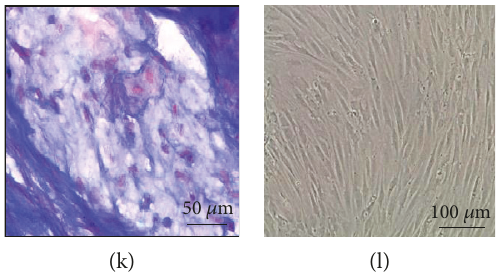
Figure 3: Characterization of canine AT-MSCs. (a) Phase-contrast micrograph showing AT-MSCs adhered to a plastic culture fl ask at passage 3. (b) Immunophenotypic pro fi le. Flow cytometry analyses were carried out for each marker separately. The percentages of positive cells are shown in the graph. (c, d) Adipogenic di ff erentiation. Cells were grown in regular (c) or adipogenic (d) medium for 21 days, fi xed, and stained with oil red O to evaluate the presence of red-colored lipid drops in the cytoplasm. The insets correspond to higher magni fi cations of areas boxed in (d). (e – h) Osteogenic di ff erentiation. Alkaline phosphatase (ALP) activity was measured after 7 or 14 days of culture in osteogenic medium (right bars) or regular medium (left bars), as indicated in (e). Bars labeled with the same letters are signi fi cantly di ff erent ( p ≤ 0 05 ). Von Kossa staining revealed more mineralization foci at day 7 in induced cells (f). (g, h) show the absence or presence of mineralization deposits in osteogenic and regular medium, respectively. (i – l) Chondrogenic di ff erentiation. (i) Scheme representing the micromass assay. (j) Micromass generated after 21 days in chondrogenic medium after being processed, cut, and stained with alcian blue and counterstained with neutral red to evidence cell nuclei. (k) Selected area in (j), showing the typical structure of cartilage tissue with nuclei eccentrically placed in lacunae and an alcian blue-stained matrix revealing the presence of glycosaminoglycans. (l) No micromasses were observed after 21 days in control medium. Conversely, the droplets were disassembled giving rise to a homogeneous cell